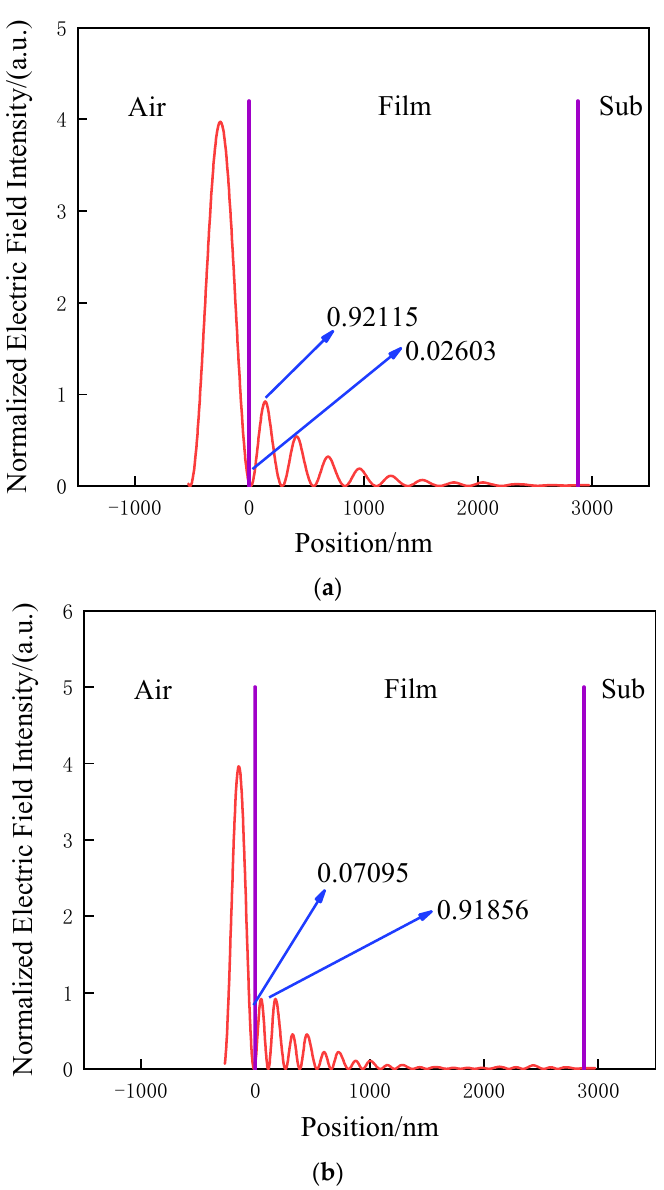
Figure 7. Relative standing-wave electric field intensity distribution of the non-regularized highly reflective Ta 2 O 5 /SiO 2 film at ( a ) 1064 nm and ( b ) 532 nm ( The red line indicates the simulated electric field strength of the film, the purple line at the air-film interface indicates the film surface location, and the purple line at the film-substrate interface indicates the film thickness location ; the value of the field strength at the interface between air and film is the interfacial electric field strength, and the first peak of the electric field strength inside the film is the peak electric field strength).